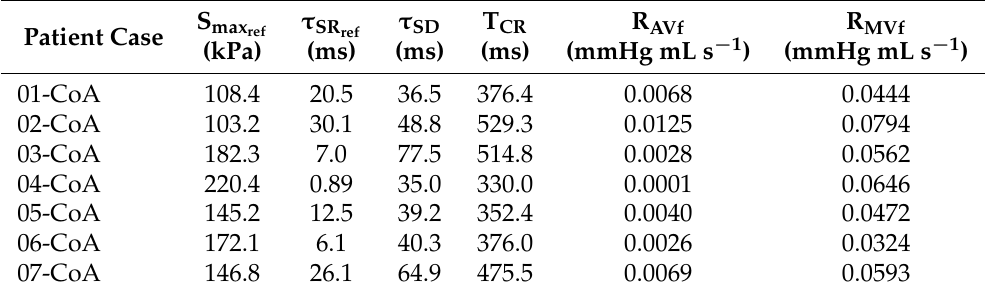
Table A6. Estimated parameter values of the personalised Tanh model and the personalised valve flow models for each patient case.